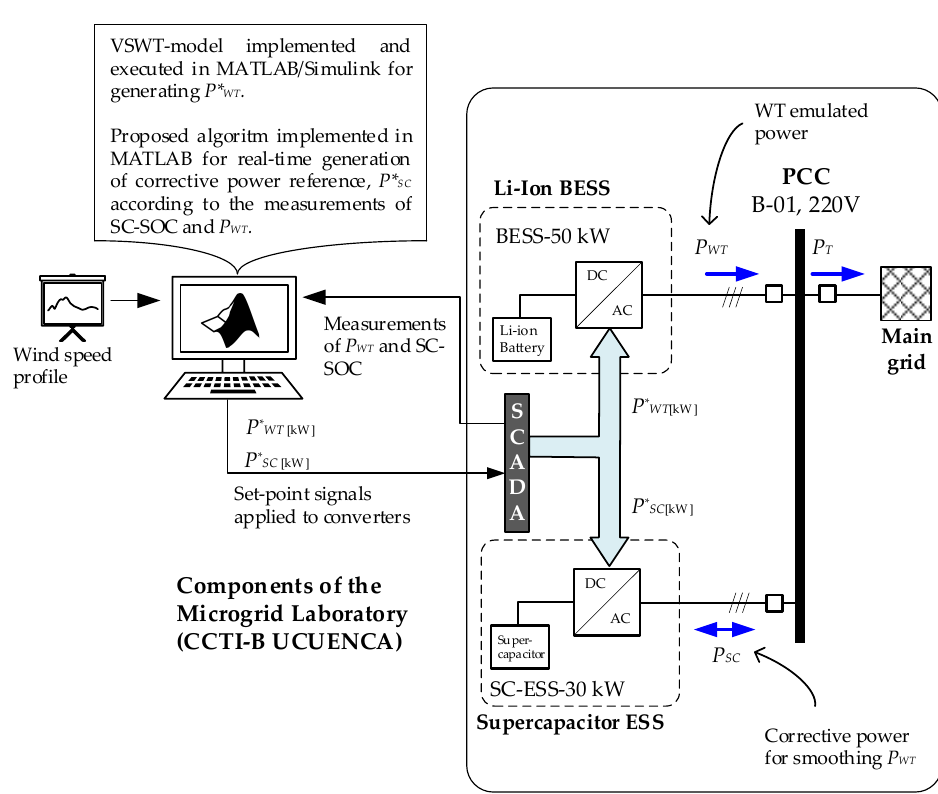
Figure 14. Implementation of the test bench in the laboratory.